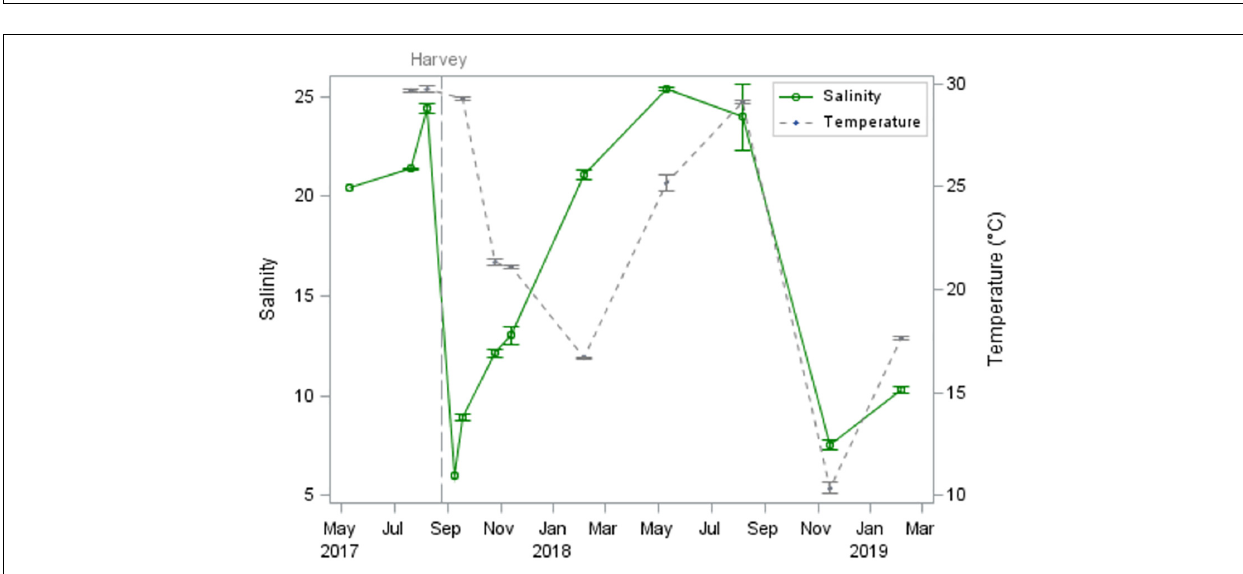
FIGURE 1 | Map of the study area, including Texas coastline and Gulf of Mexico (A) , the Mission-Aransas Estuary and St. Charles Bay, TX (B) , and sampling locations (C) . The Hurricane Harvey track is shown as a dashed line.